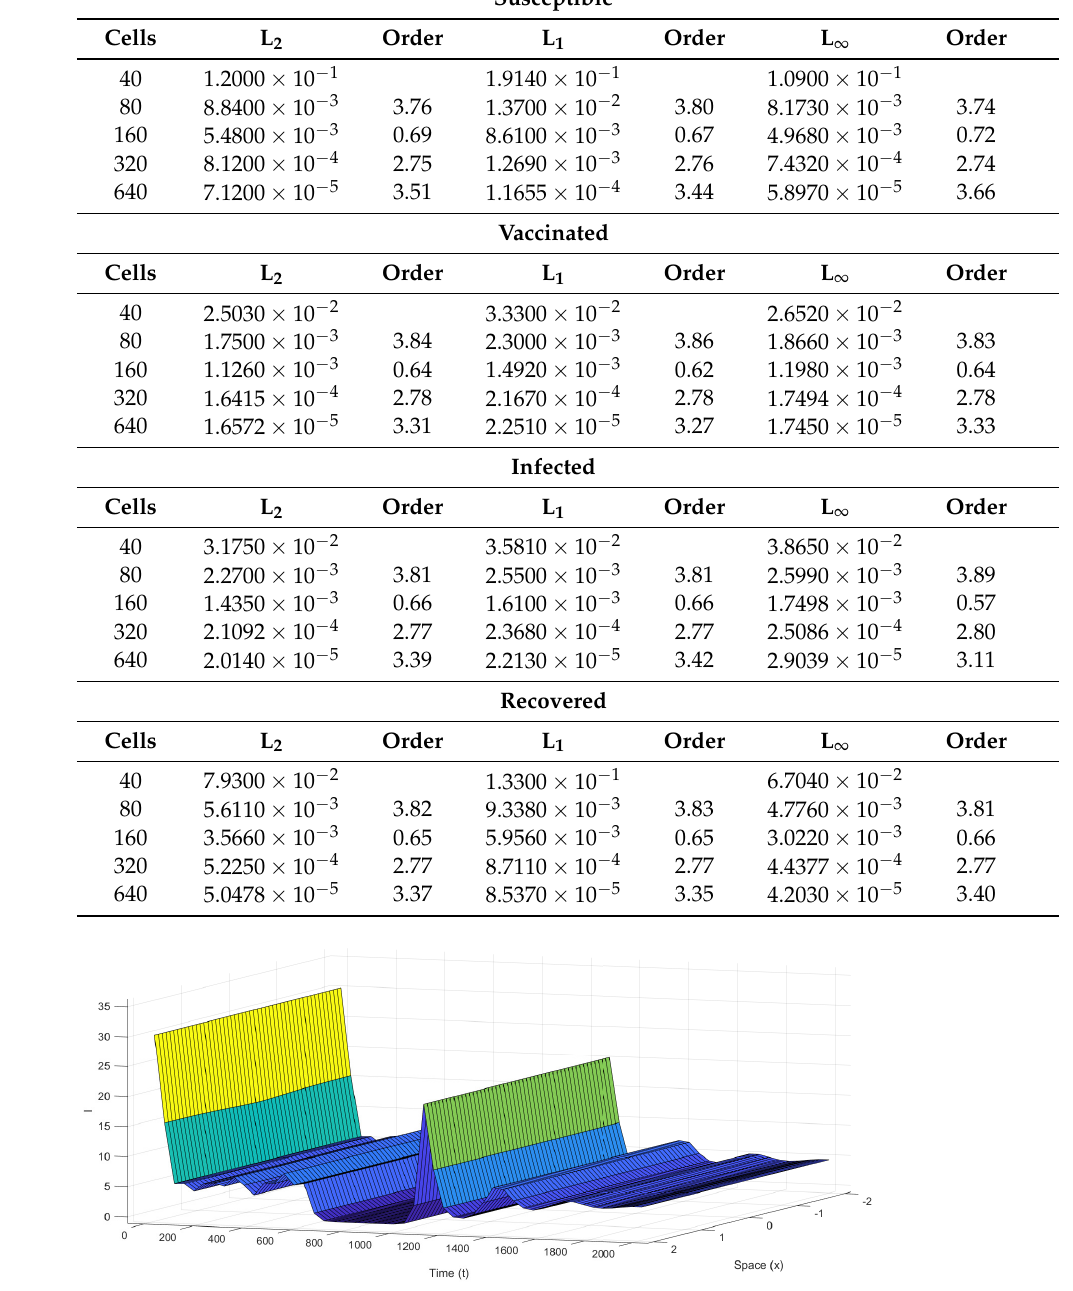
Figure 6. PDE Numerical simulation of infected individuals ( I ), with Equation